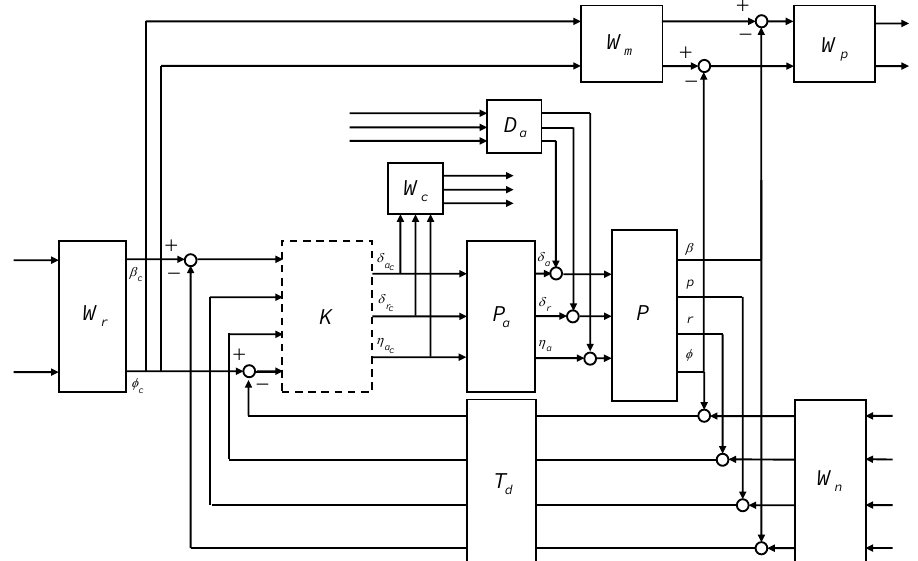
Figure 19. Closed-loop interconnection of the lateral-directional